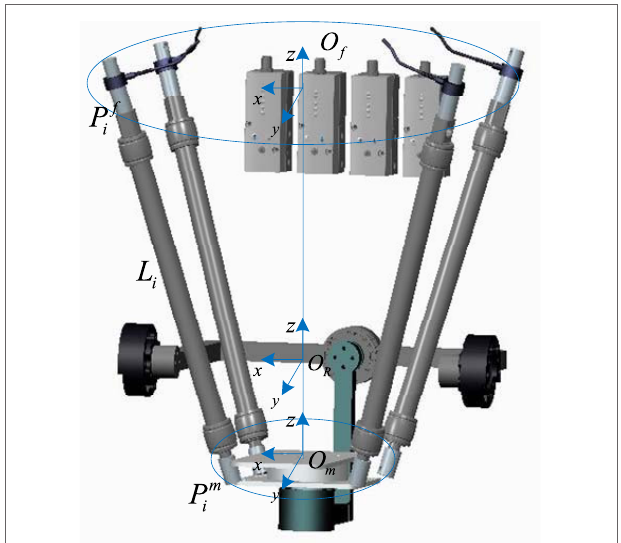
FIGURE 2 | Geometric model the developed soft ankle rehabilitation robot (ARBOT). Define O f is coordinate of fixed platform and the rotation center of end effector is denoted by O m , P f i and P m i are the connection point vectors of the upper fixed platform and the lower moving platform,